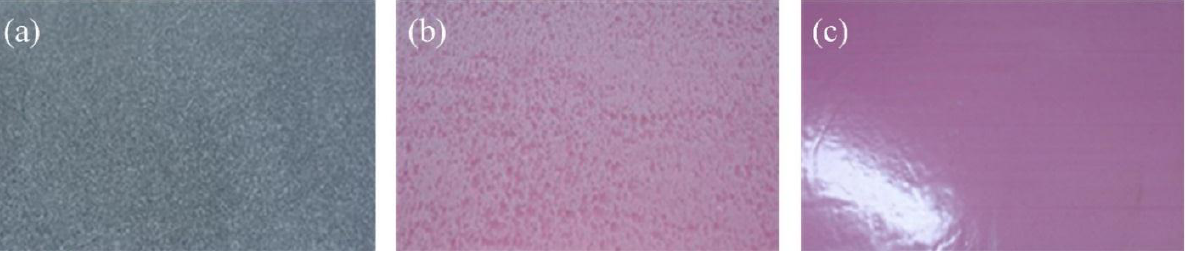
Figure 3. ( a ) Expanded polystyrene (EPS) foam; ( b ) extruded polystyrene (XPS) foam with roughened surface; ( c ) XPS foam with traction-free